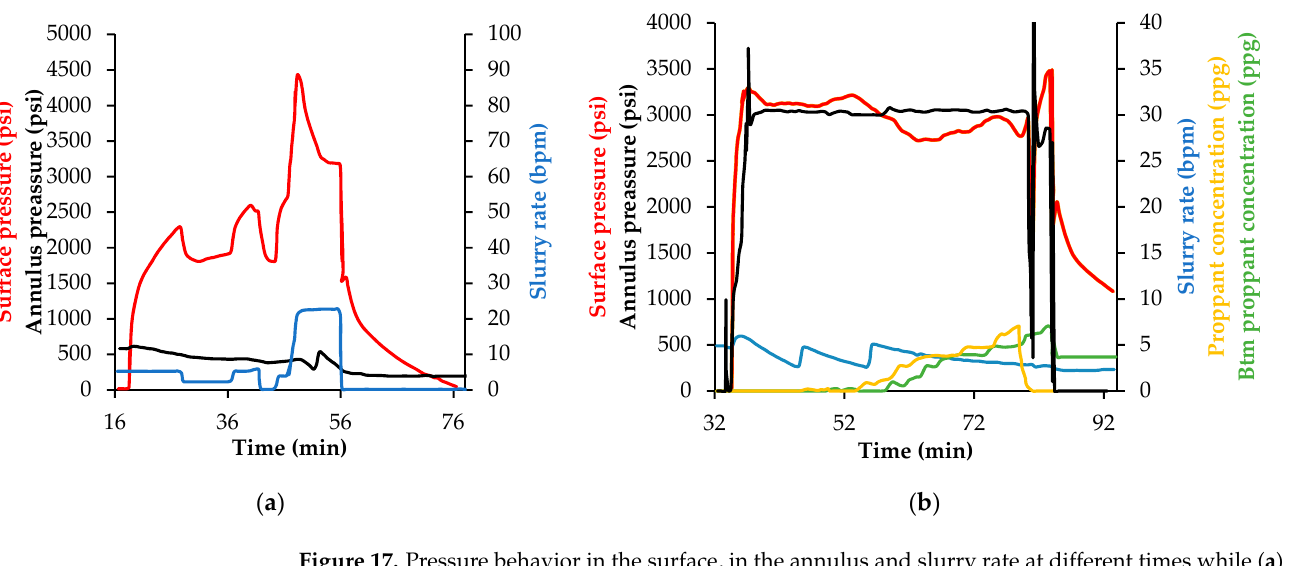
Figure 17. Pressure behavior in the surface, in the annulus and slurry rate at different times while ( a ) opening the fracture and ( b ) injecting the proppant measuring flow rate in surface and the bottom of the well in the Castilla field application.